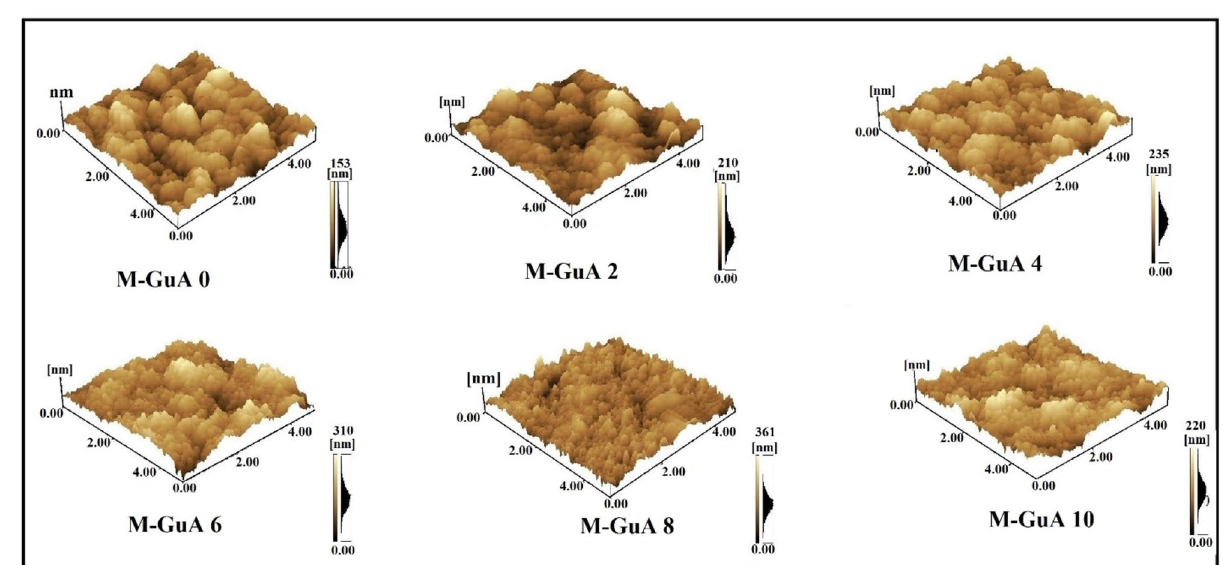
Figure 5. AFM 3-Dimentional images of M-GuA